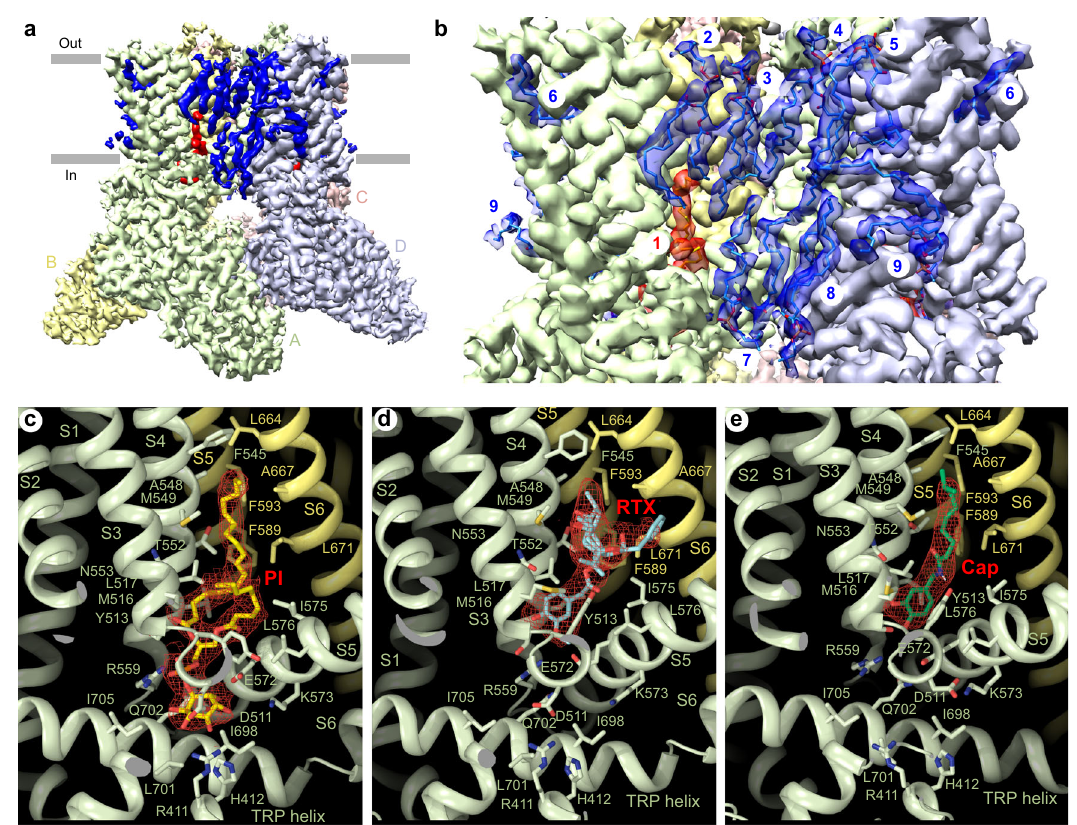
Fig. 3 Lipids and ligands. a Cryo-EM density for the apo-state full-length sqTRPV1, with the lipid densities coloured red or blue. b Close-up view of the membrane region, with the molecules of lipid shown in sticks and numbered. c – e Close-up view of the vanilloid site (site 1 in b ) in the apo-state structure harbouring the molecule of phosphatidylinositol ( c ), RTX-bound ( d ) and capsaicin-bound ( e ) structures. The molecules of phosphatidylinositol, RTX and capsaicin are shown as yellow, blue and green sticks, respectively, with the corresponding cryo-EM density shown in